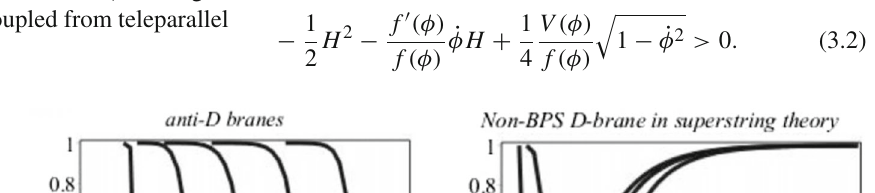
Fig. 5 Phase space diagram for the different potentials with coupling constant f (φ) = φ